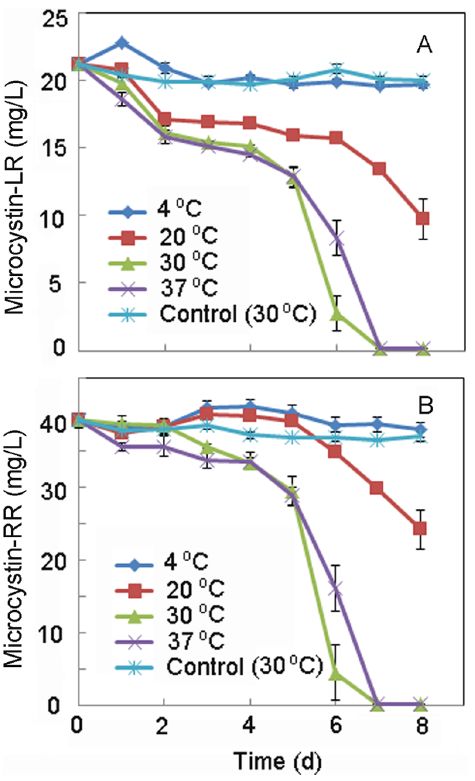
Figure 2. Effect of incubation temperature on the degradation of MC-LR (A) and MC-RR (B) by MC-LTH2.